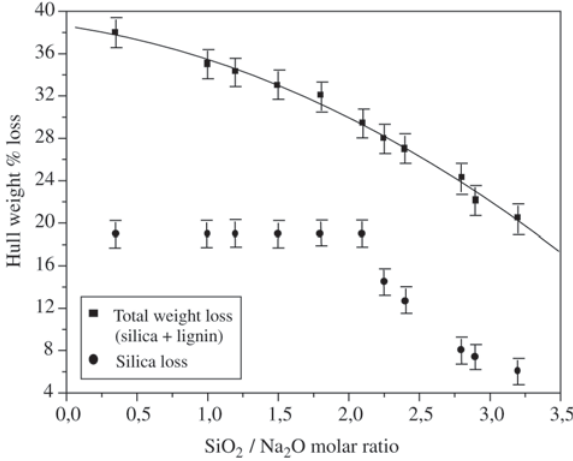
Figure 5. Silica and lignin, in wt%, dissolved from the hull by sodium hydroxide attack at 100 °C, and dependence on the SiO molar